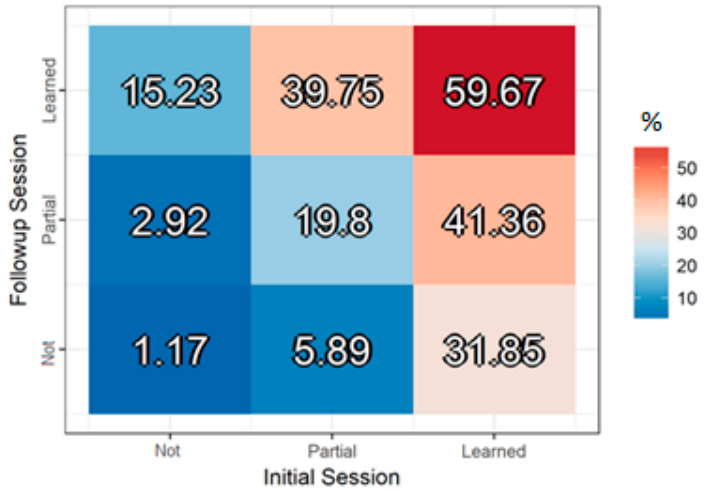
Figure 2. Surprise recall test accuracy (%) based on learning in the initial (first) and follow-up (second) training sessions collapsed across language familiarity and imageability.